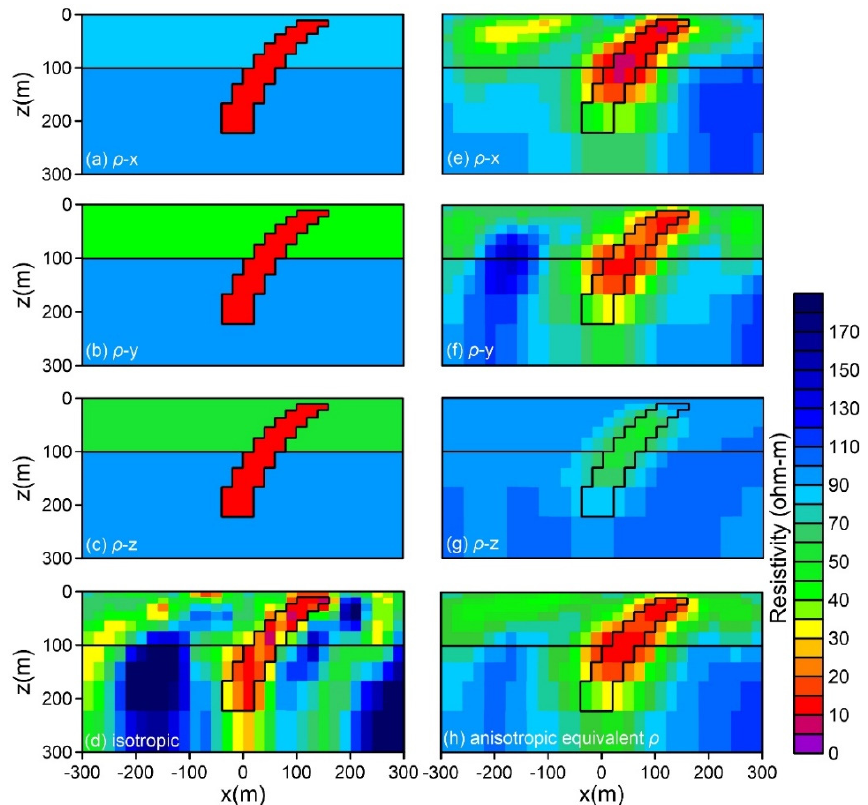
Figure 7. Anisotropic and isotropic inversions for a model with a triaxial anisotropic host rock and isotropic ore-body. ( a )–( c ) show the true model in x , y , and z -directions; ( d ) shows the isotropic inversion result; ( e )–( g ) show the anisotropic inversion results in x , y , and z -directions; ( h ) shows the equivalient resistivity ρ h calculated from the anisotropic inversion results (all slices are displayed at y = 40m) .